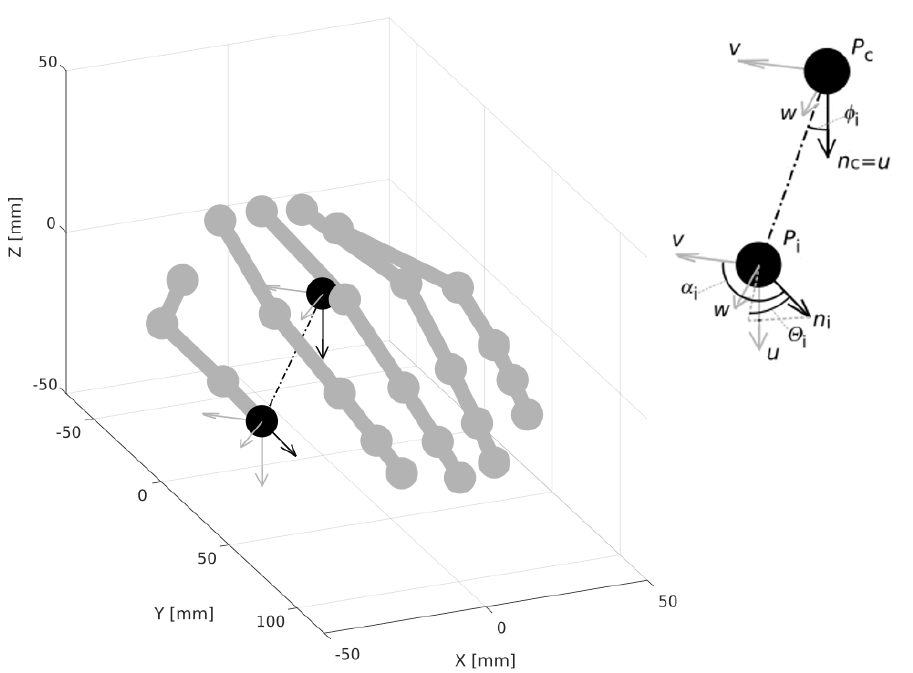
Figure 2. Feature vector